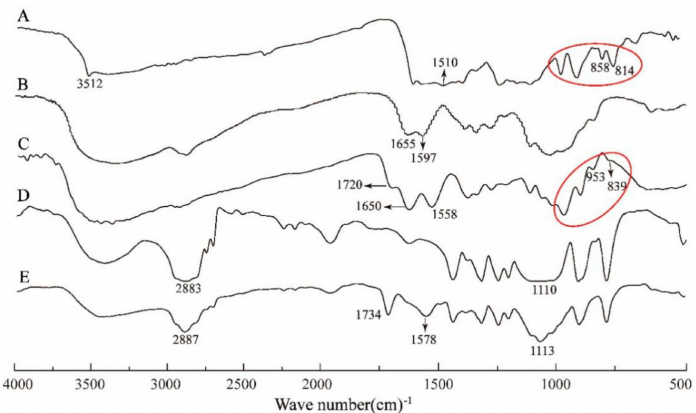
Figure 2. Fourier transform infrared (FTIR) spectra of: Curcumin (CUR) ( A ); Chitosan (CS) ( B ); CUR-grafted-CS (CCS) ( C ); polyethylene glycol (PEG) ( D ); and PEGylated CUR-grafted-CS (PCC) ( E ).